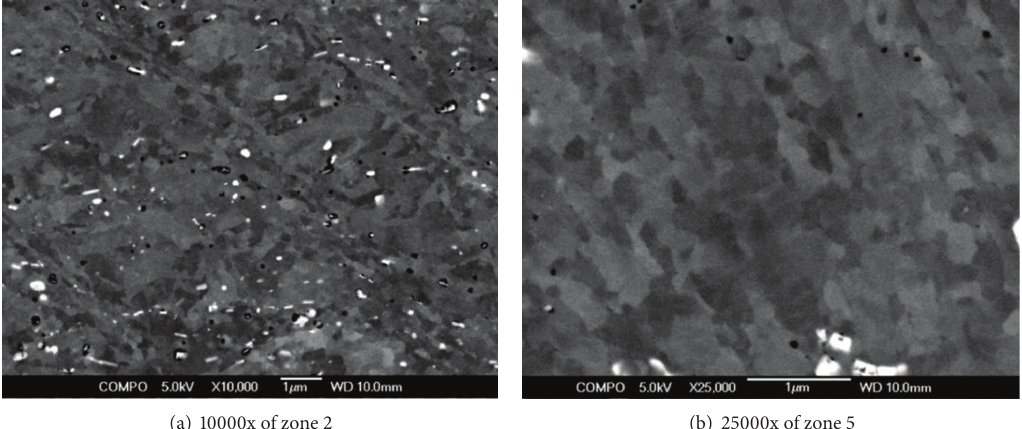
Figure 10: SEM micrographs of the blade with N2 as starting material and forged at 200 ∘ C.